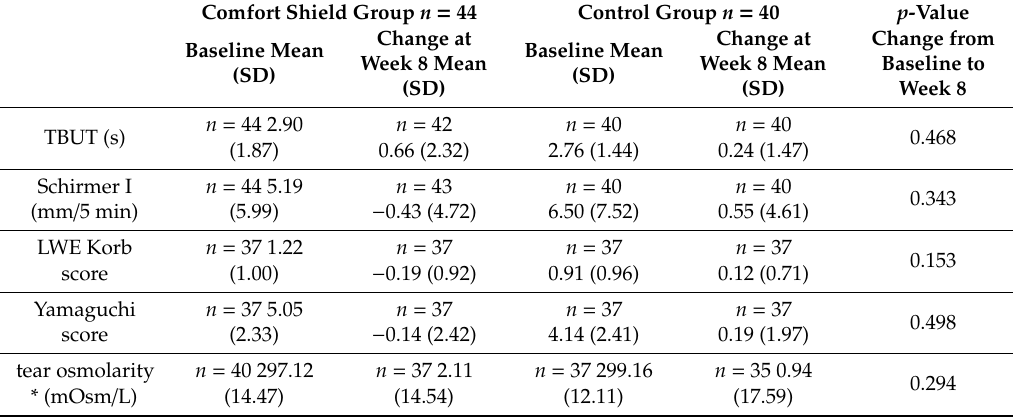
Table 12. Values at baseline and change from baseline to week 8 for tear film break-up time (TBUT), Schirmer I, lid wiper epitheliopathy (LWE) Korb score, Yamaguchi score, and tear osmolarity—PPS ( n = 84). Comfort Shield Group n = 44 Control Group n = 40 p